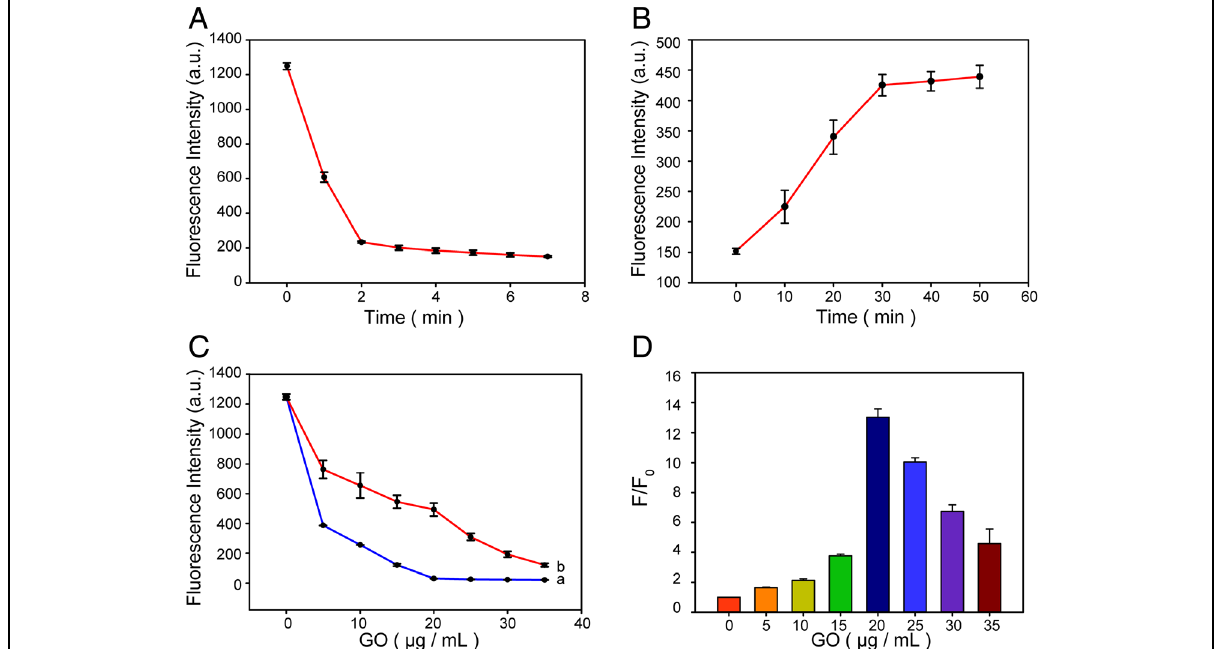
Fig. 5 Optimization of experimental conditions. a Fluorescence quenching of FAM-apt (20 nM) in Tris-HCl buffer by GO as a function of time. b Fluorescence restoration of FAM-apt in GO solution by CCRF-CEM (1 × 10 6 ) as a function of time. c Effect of GO concentration on the fluorescence intensity of FAM-apt in the absence (curve a) and in the presence (curve b) of 1 × 10 6 CCRF-CEM cells. d The fluorescence intensity rate ( F / F 0 ) of FAM-apt by 1 × 10 6 CCRF-CEM cells as a function of GO concentration. Excitation 490 nm